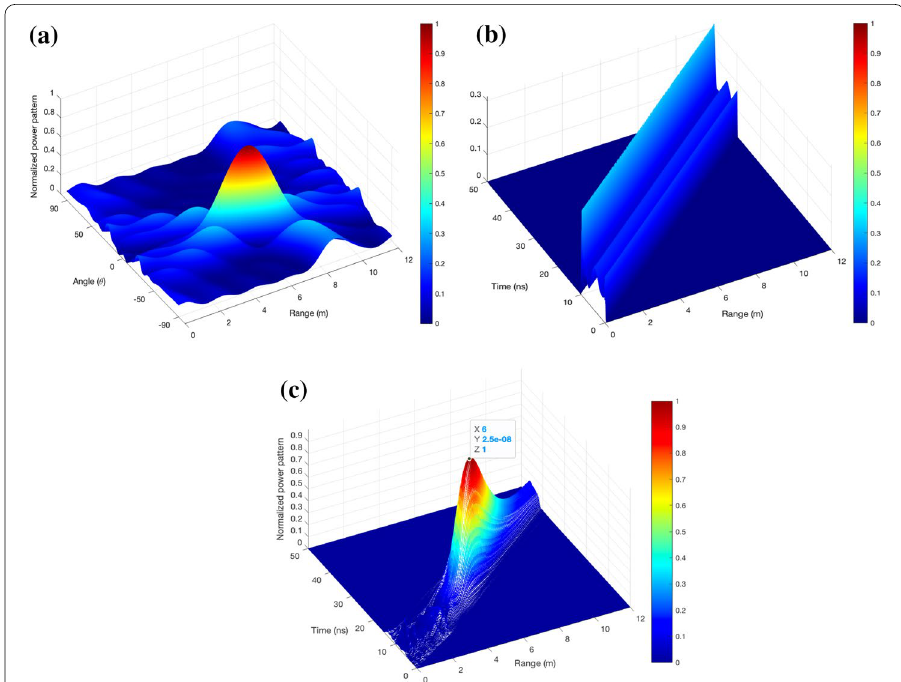
Fig. 12 Significance of the wave propagation effect. a C‑TMOFO FDA original time‑invariant beampattern. b C‑TMOFO FDA corrected time‑variant beampattern. c Original time‑variant beampattern of the short‑range FDA radar based on arc‑tangent